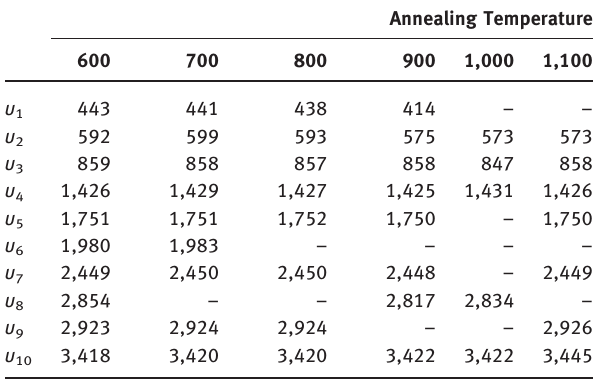
Table 2: FTIR data